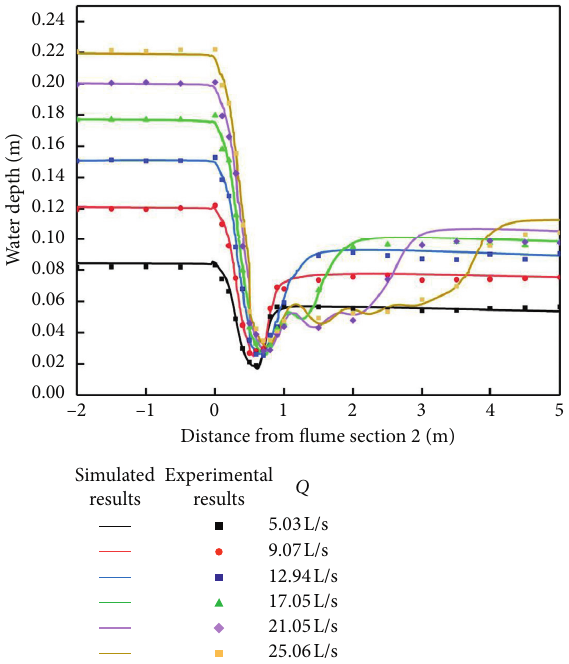
Figure 6: Comparison of the simulated and experimental results of free water surface line.